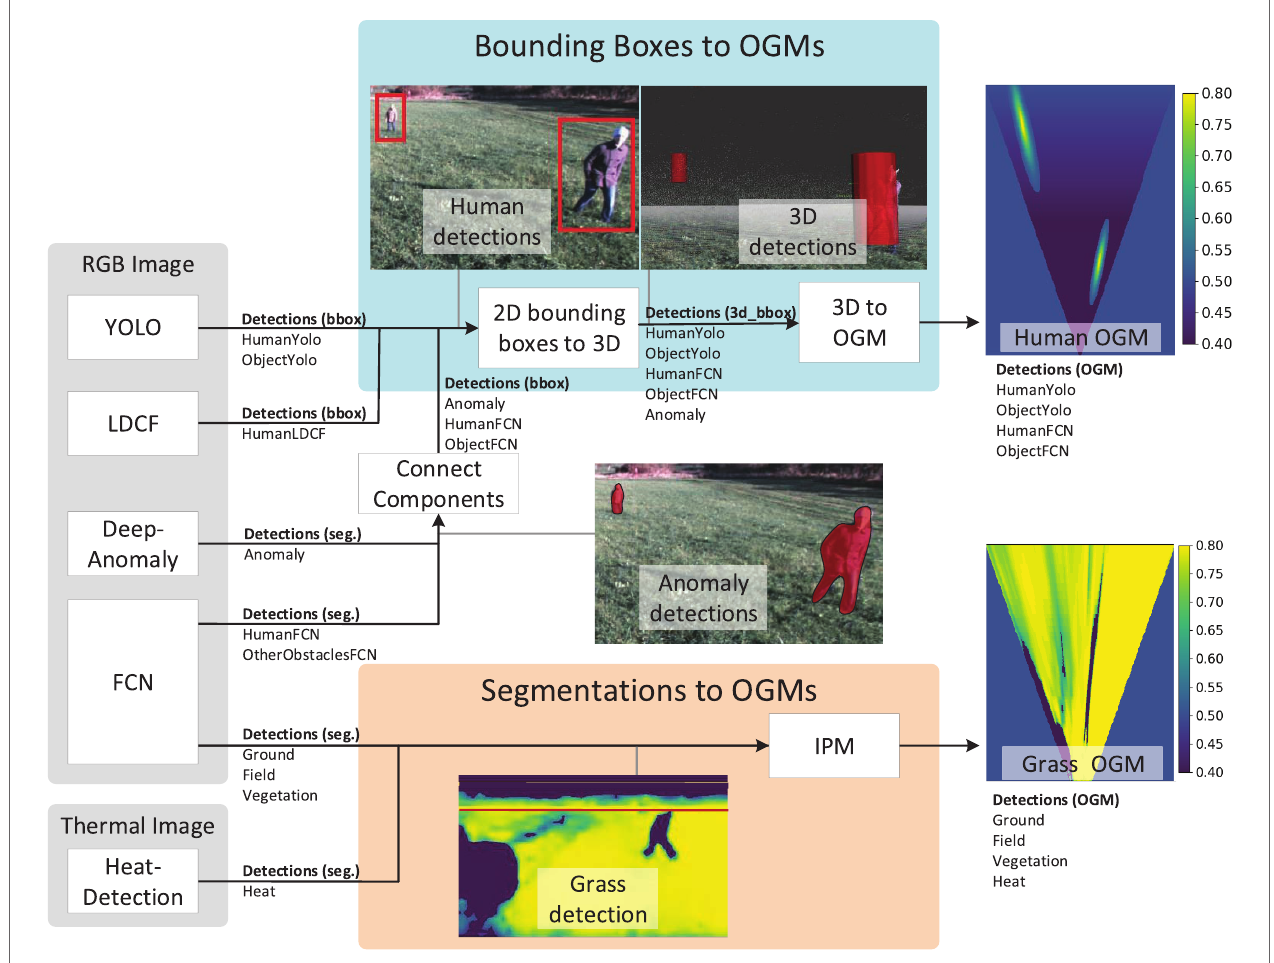
FIGURE 5 | Converting detections to OGMs. Written and informed consent was obtained from all depicted individuals.